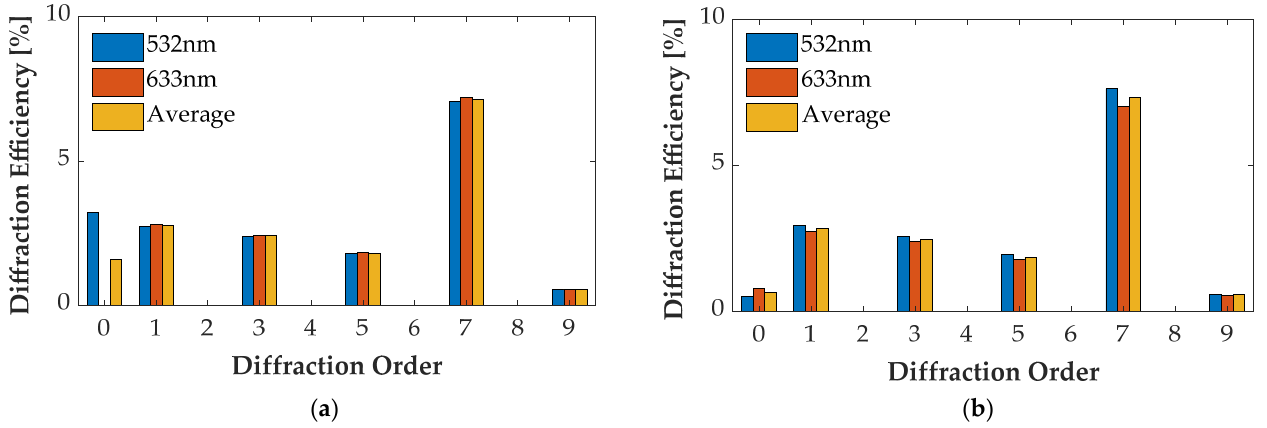
Figure 24. Diffraction efficiency of AH74_opt3. ( a ) AH74_opt3 with the groove depth of 158.25 nm; ( b ) AH74_opt3 with the groove depth of 143 nm.